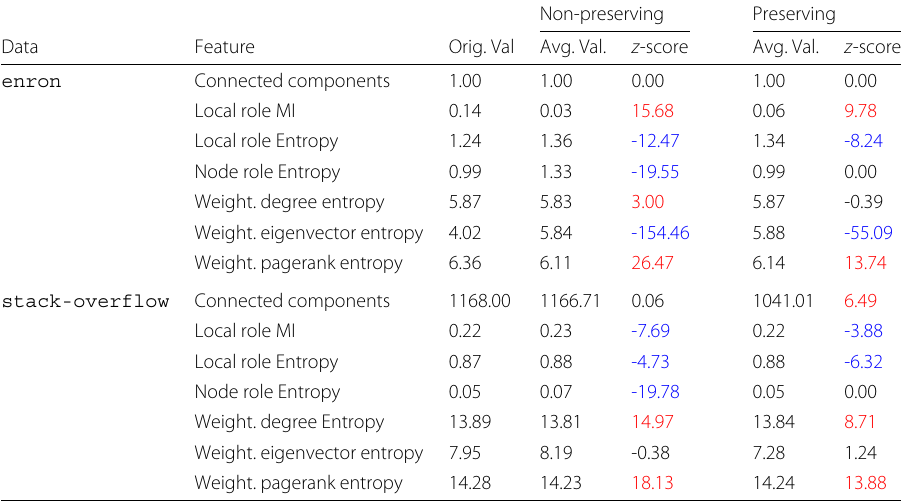
Table 2 The significance of multiple observables across the enron and stack-overflow data